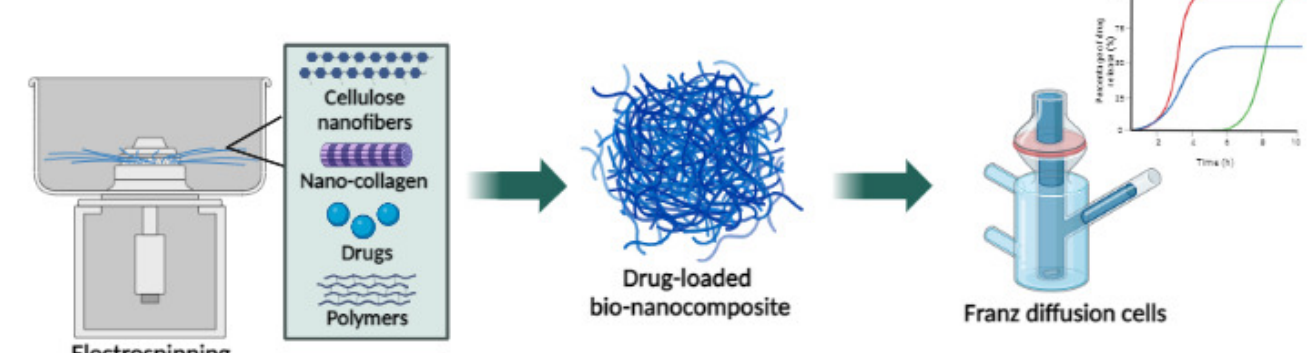
Figure 4. Schematic represents the bio-nanocomposite produced via the electrospinning method and drug release of ketorolac tromethamine via Franz diffusion cells, (Figure generated with Biorender (https://www.biorender.com/, accessed on 13 March 2023).)